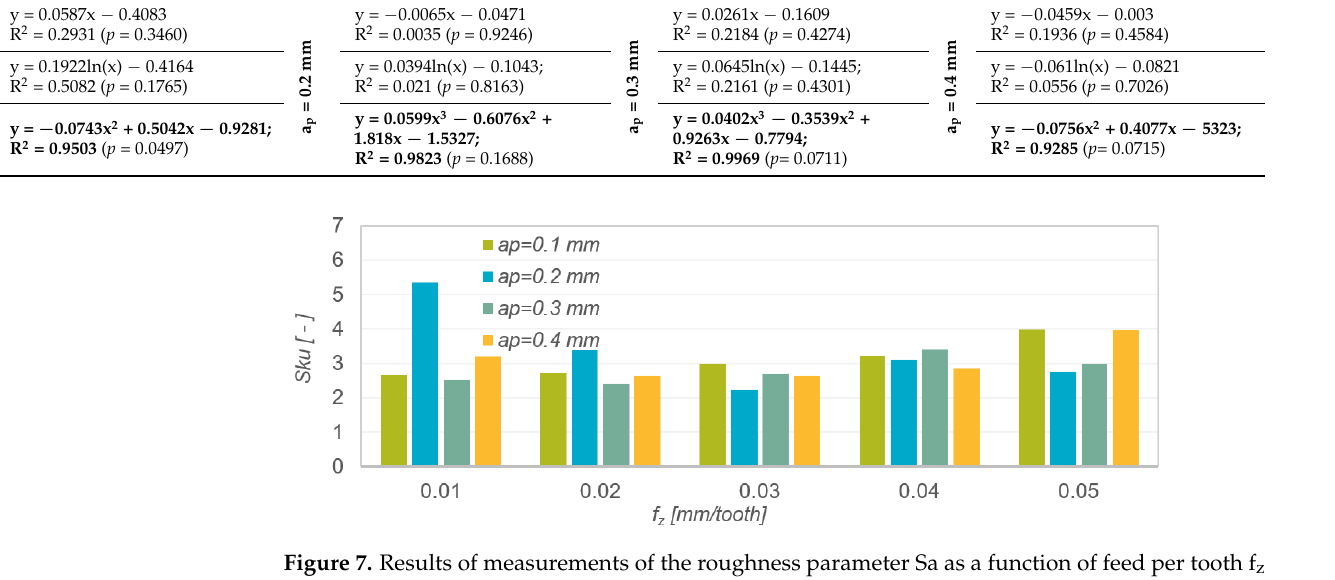
Table 6. Results of mathematical modelling of the Ssk parameter as a function of the feed rate for different values of the depth of cut (regression functions y = Ssk(f z ); f z = x with the coefficient of determination R 2 ).